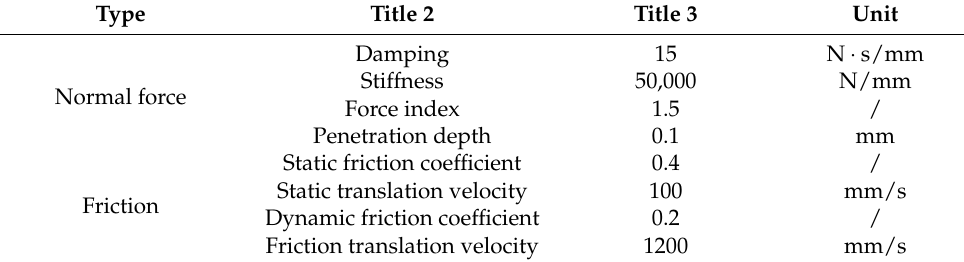
Table 3. The contact model parameters.